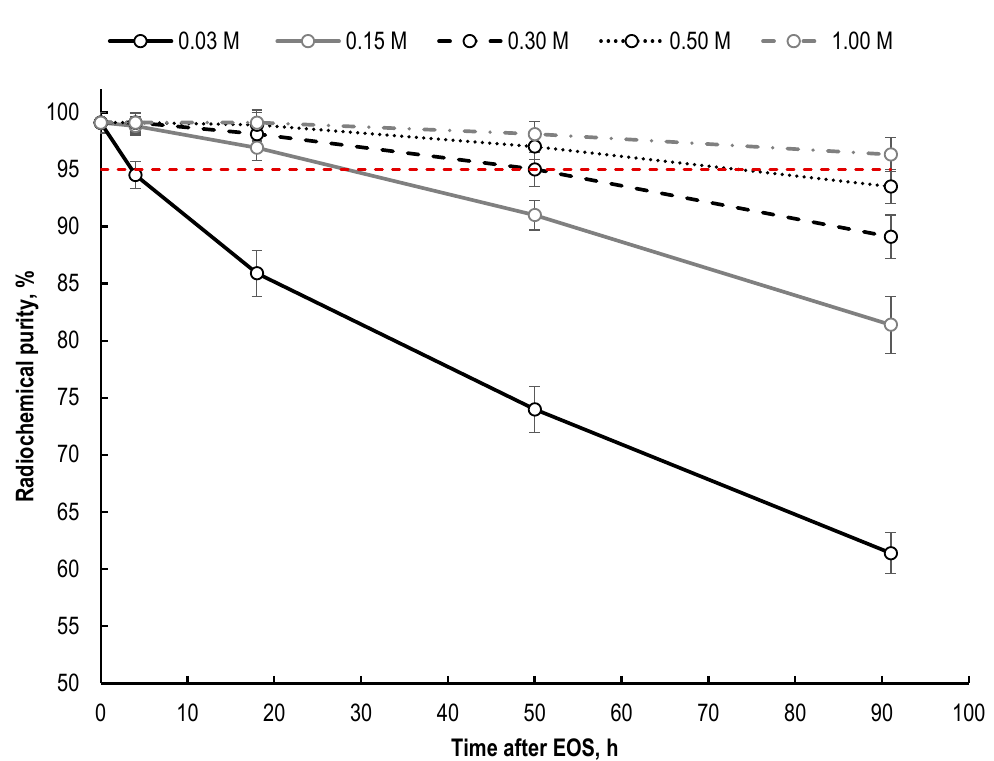
Figure 9. Time dependences of the decrease in [ 177 Lu]Lu-PSMA-617 radiochemical purity on the concentration of sodium acetate in the final preparation (sample volume—1 mL, 177 Lu activity in each sample—100 MBq, 100 µ g of PSMA-617, pH 4.5; RCP value is presented as mean ± SD, n = 3).